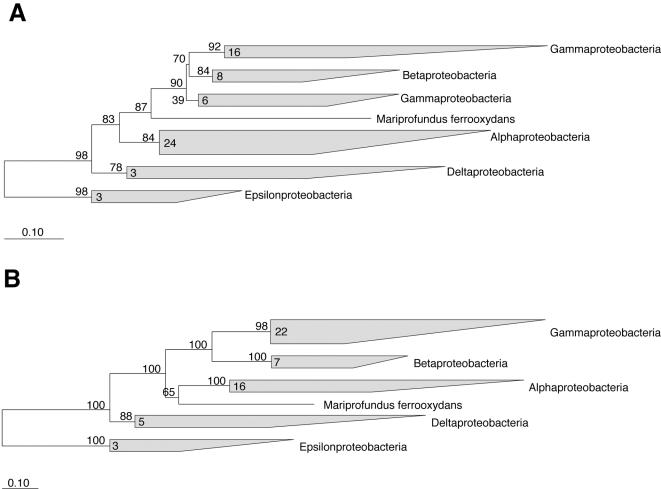
Two maximum likelihood trees showing the phylogenetic relationship of Mariprofundus ferrooxydans PV-1 to other Proteobacteria based on conserved protein sequences.Figures A and B show trees inferred from the amino acid sequences of the widely conserved RecA and GyrB proteins, respectively. The shaded clusters represent the recognized classes of Proteobacteria. The number of sequences representing each class is shown inside the cluster. The numbers at the nodes represent the per cent support for that group. The scale bar represents the estimated number of substitutions along the branches.